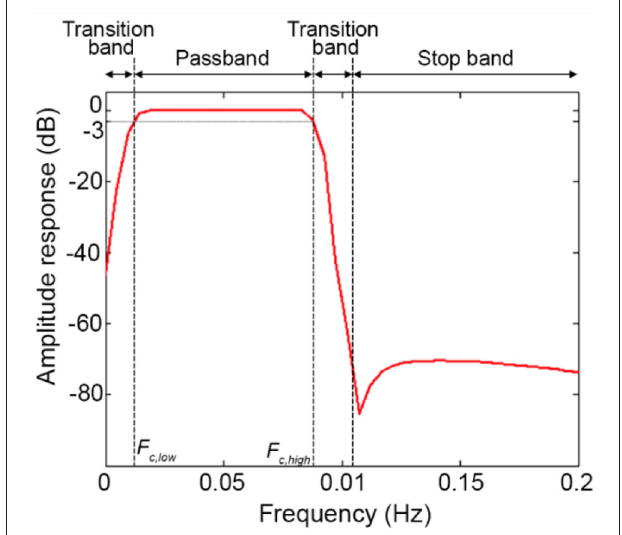
FIGURE 12 | Filter amplitude response considering a BP FIR filter with order = 1000 and F c = [0.01, 0.09] Hz.